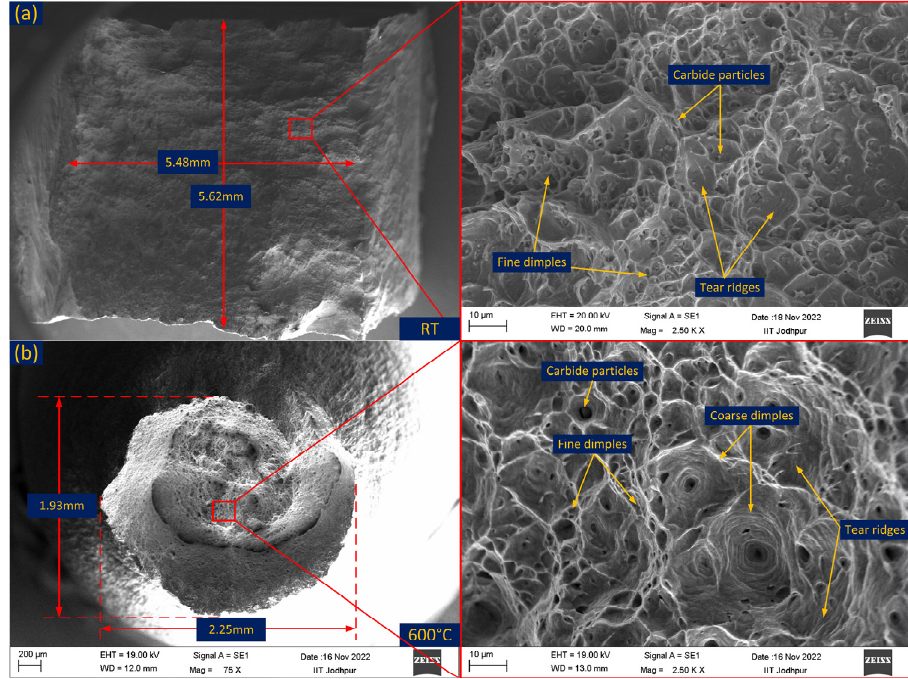
Figure 11. SEM image of the fractured tensile specimen tested at ( a ) room temperature (RT), ( b ) at 600 °C (HT).